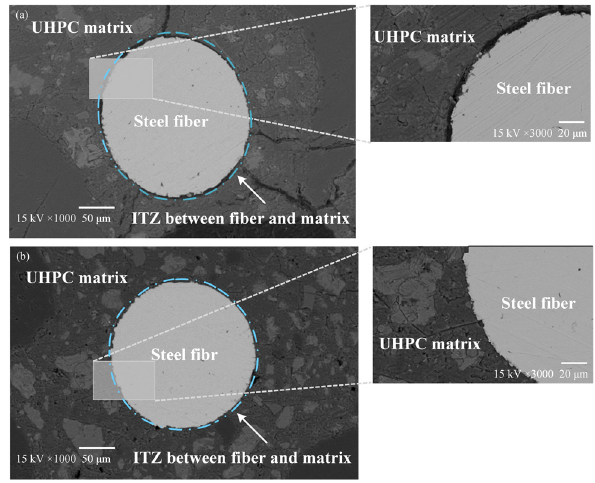
Figure 9: Morphologies of UHPC specimen without CNF and with 0.15% CNF. ( a ) ITZ between steel fi ber and matrix of UHPC without CNF. ( b ) ITZ between steel fi ber and matrix of UHPC with 0.15% CNF.